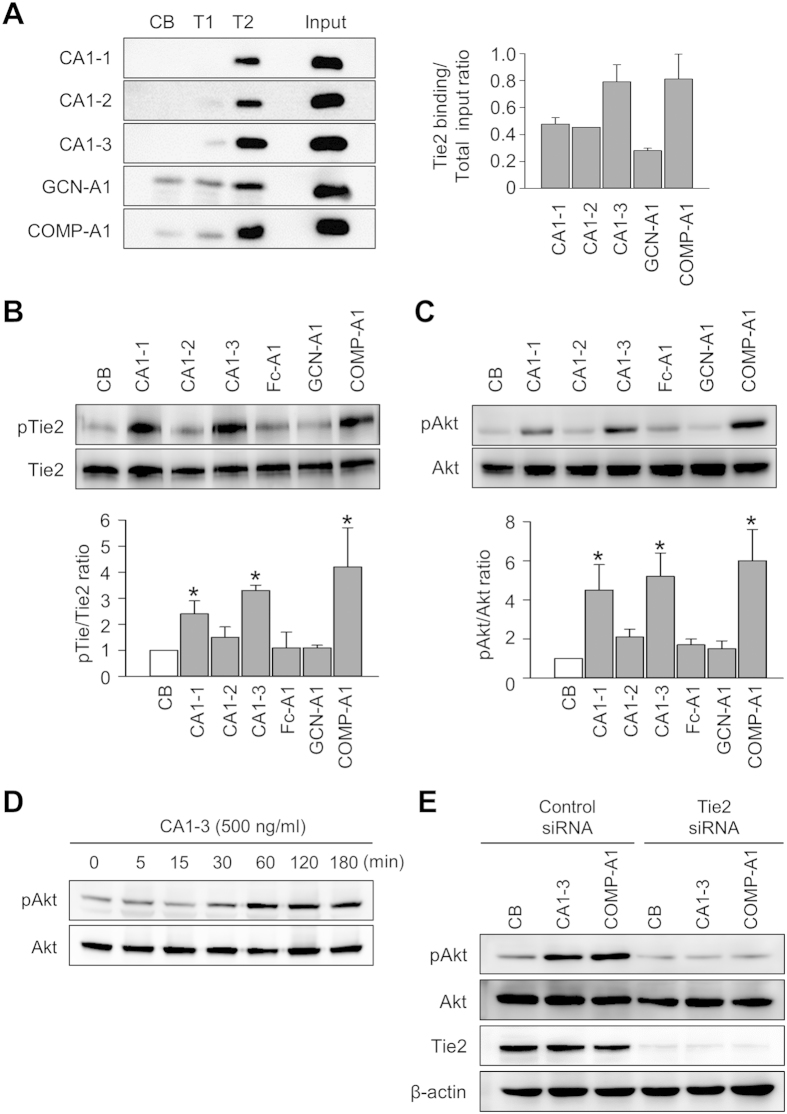
Dimeric CMP-Ang1 binds to Tie2 and activates Tie2/Akt signaling.(A) In vitro binding assay of CA1-1, CA1-2, CA1-3, GCN-Ang1, and COMP-Ang1 with control buffer (CB), Tie1-Fc (T1), or Tie2-Fc (T2). The graph shows the T2 binding ratios of each Ang1 variant over total input protein. Each graph indicates the mean ± SD from three experiments. (B,C) Serum-starved HUVECs were treated with either control buffer (CB), 500 ng/ml of CA1-1, CA1-2, CA1-3, Fc-Ang1, GCN-Ang1, or COMP-Ang1 for 15 min for Tie2 phosphorylation (B) or for 30 min for Akt phosphorylation (C). The relative ratio of phospho-Tie2 (pTie2) to Tie2 or phospho-Akt (pAkt) to Akt of CB is arbitrarily given as 1. Each graph represents means ± SD from three experiments. *p < 0.05 versus CB. (D) The Akt phosphorylation activity of CA1-3 was measured in a time-dependent manner. (E) HUVECs were transfected with Tie2 siRNA or control siRNA. At 24 hr after transfection of siRNA, 500 ng/ml of CA1-3 or COMP-Ang1 were added for 30 min, and then cell lysates were analyzed by western blotting using antibodies against pAkt, Akt, Tie2, or β-actin.